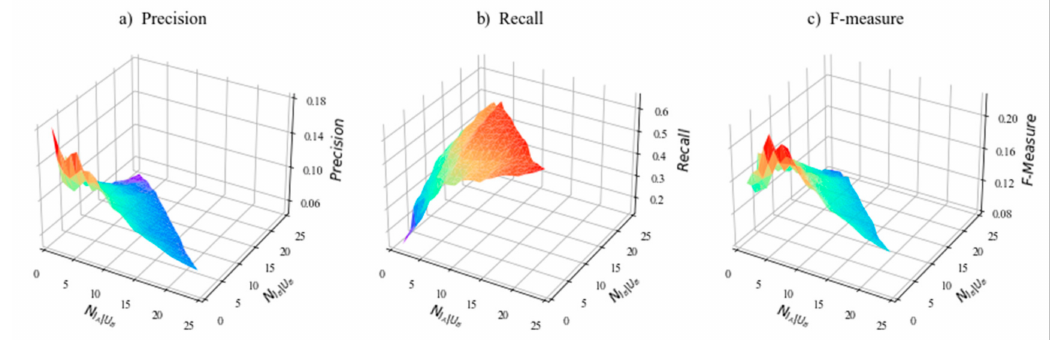
Figure 10. The changes of three evaluation indicators with the combination of inactive